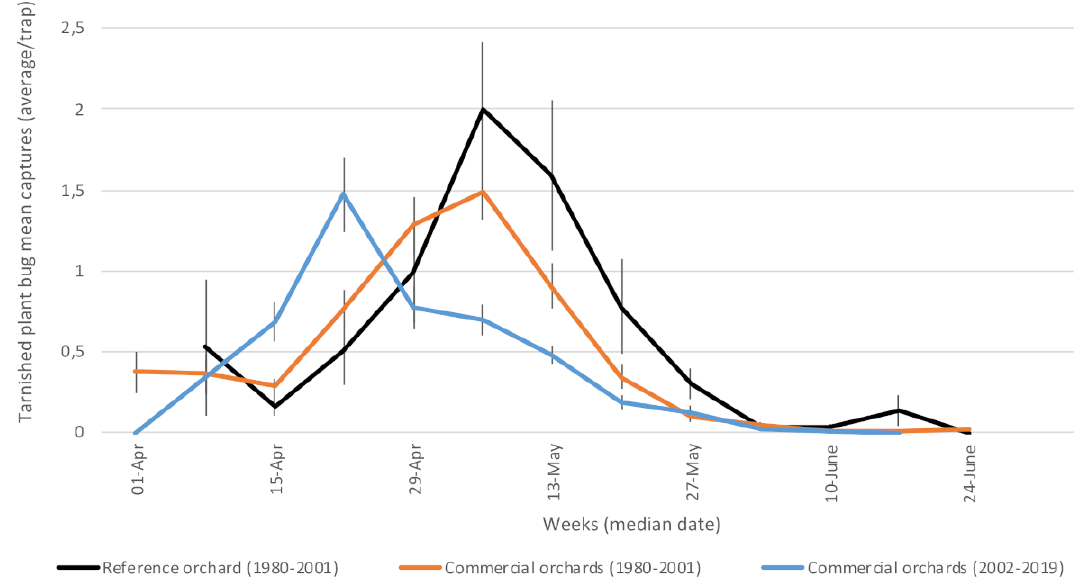
Figure 2. Average captures of tarnished plant bug adults in participating orchards. Reference (insecticide-free) orchard located at Frelighsburg, Qc (Agriculture and Agri-Food Canada, 1980–2001). Commercial orchards located at Franklin, Hemmingford, Oka, Rougemont and Saint-Paul-d’Abbotsford. Vertical bars represent standard